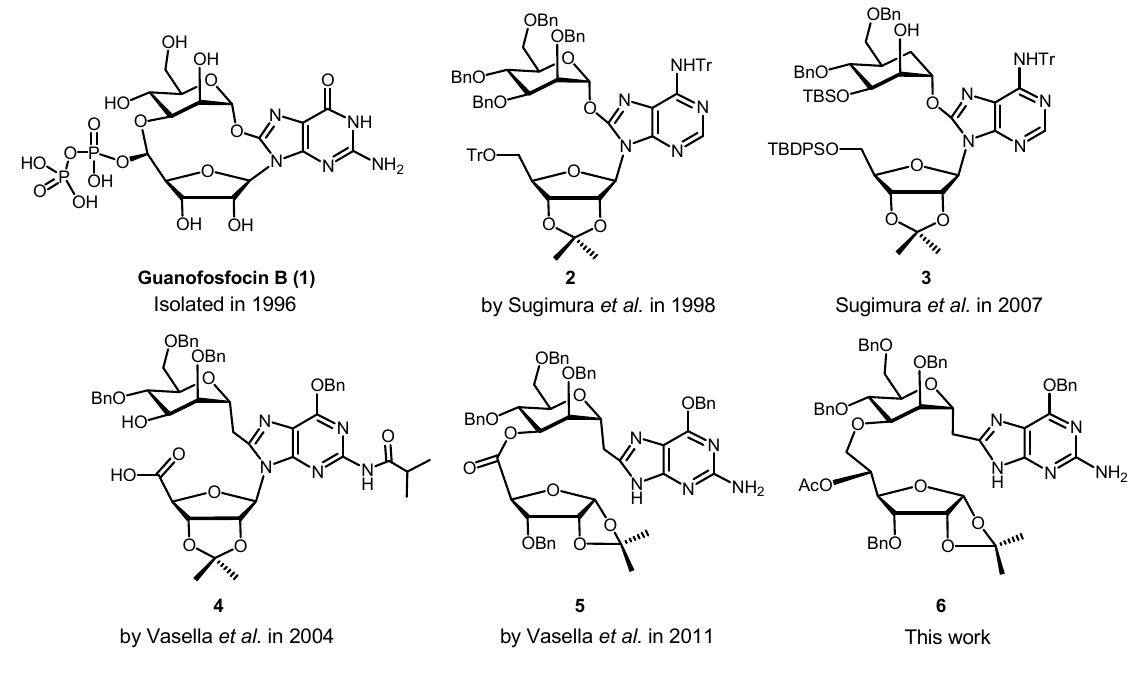
Figure 1. Compounds prepared on the way to stable analogues of